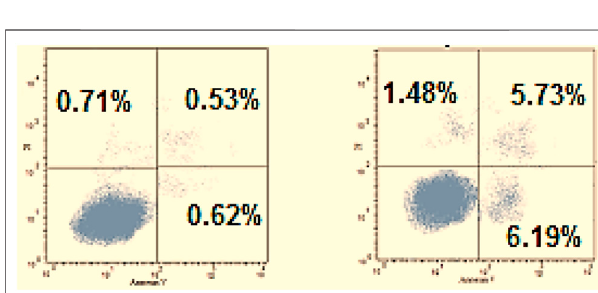
FIGURE 5 | In fl uence of 6c on the percentage of annexin V-FITC- positive staining in HepG-2 cells.